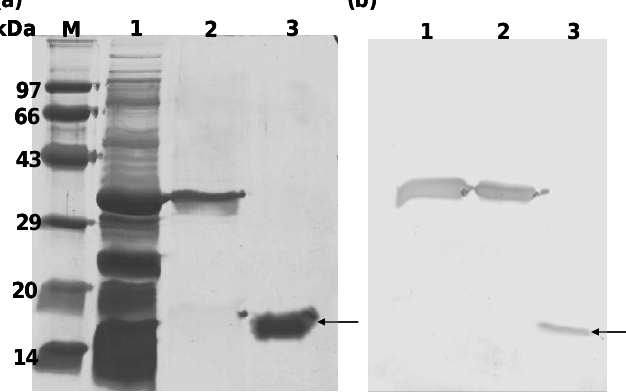
Figure 3. SDS-PAGE and Western blot analysis of purified hGMCSF. Soluble fraction containing TRX-hGMCSF was passed through Ni-NTA column and the fractions containing pure TRX-GMCSF were dialyzed and bound to Ni-NTA a second time in batch mode. The fusion protein was cleaved in the bound state with enterokinase enzyme in the presence of 1 mM CaCl . The flow through containing hGMCSF was collected and 2 analyzed. ( a ) SDS-PAGE showing different purification steps. Lane M: Molecular weight Marker; lane 1: Soluble fraction containing TRX-hGMCSF fusion; lane 2: Purified TRX-GMCSF fusion, lane 3: purified hGMCSF; ( b ) Immunoblot using mouse monoclonal anti-hGMCSF antibody to confirm the identity of hGMCSF. Lane 1: Soluble fraction containing TRX-hGMCSF fusion; lane 2: Purified TRX-GMCSF fusion; lane 3: purified hGMCSF. Arrows represent the purified hGMCSF in both SDS-PAGE and immunoblot.